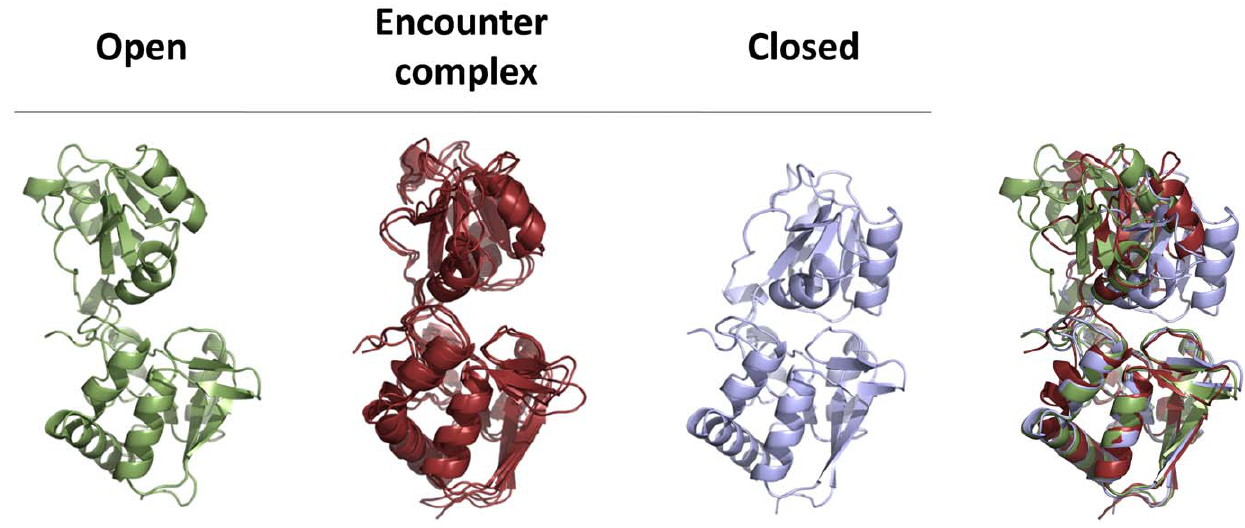
Figure 5. Structural comparisons between encounter complex and X-ray apo (or open) and bound (or closed) structures for the LAO protein. The X-ray apo (PDB ID: 2LAO) and bound structure (PDB ID: 1LAF) are shown in green and light blue respectively. Three representative conformations from the encounter complex state are superimposed and shown in red. These three conformations are representative of 10,000 randomly selected conformations from the encounter complex state (i.e. they have the smallest protein C a RMSD to all the rest of the randomly selected conformations and are, therefore, the most central/typical of the state). In the right panel, the open, closed X-ray structures are overlaid with one of the representative conformations from the encounter complex state.